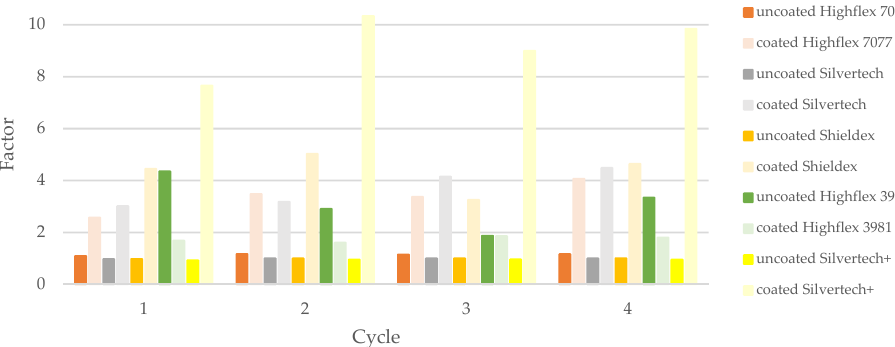
Figure 12. Factor of resistance change of the uncoated substrate as comparison to the coated substrates to illustrate the influence of the coating on the sensitivity of the